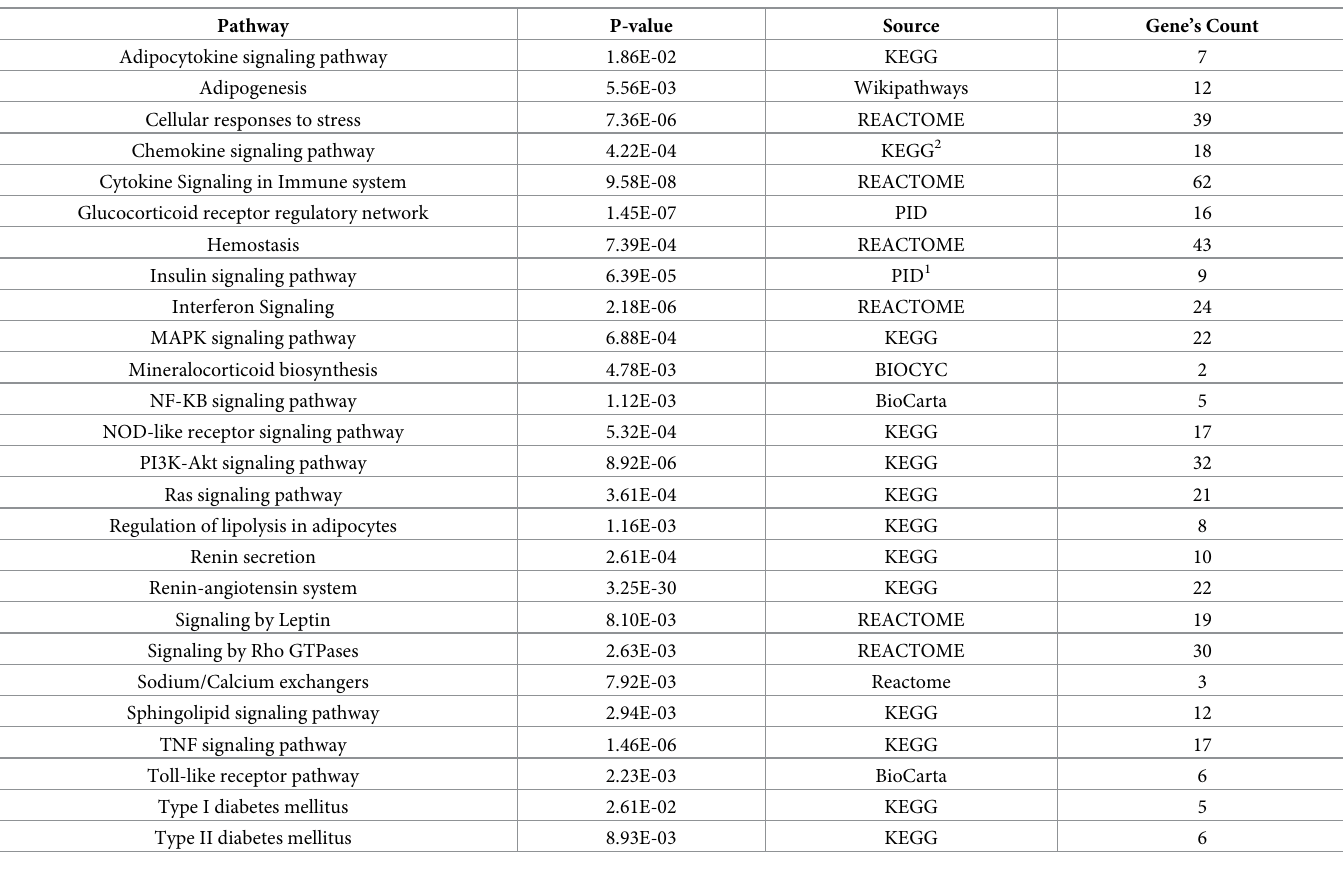
Table 4. The enriched pathways that are closely associated with obesity or obesity related diseases.